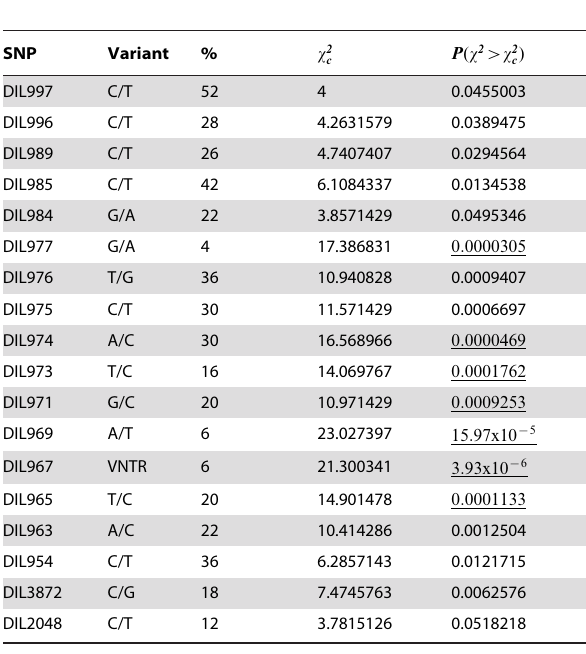
The third, fourth, and fifth columns show the percentages of missing data, the TDT statistics for complete data, and uncorrected p-values at 5% significance level. The significance SNPs are shown by underlined p -values for Bonferroni at 0.05% significance